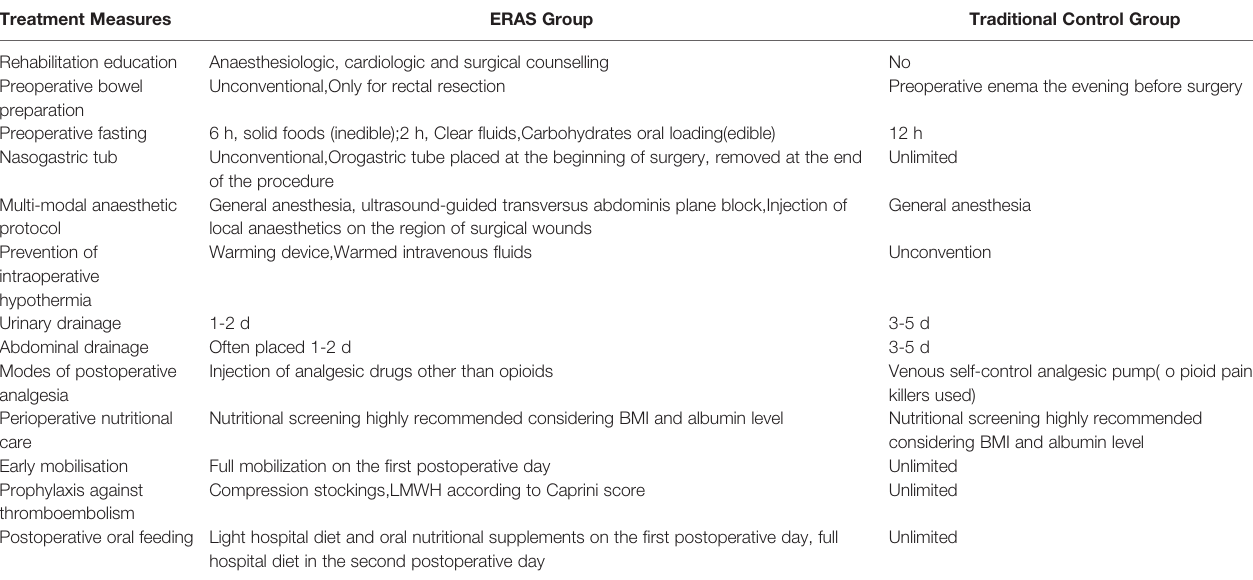
TABLE 1 | Difference of perioperative management between ERAS group and traditional control